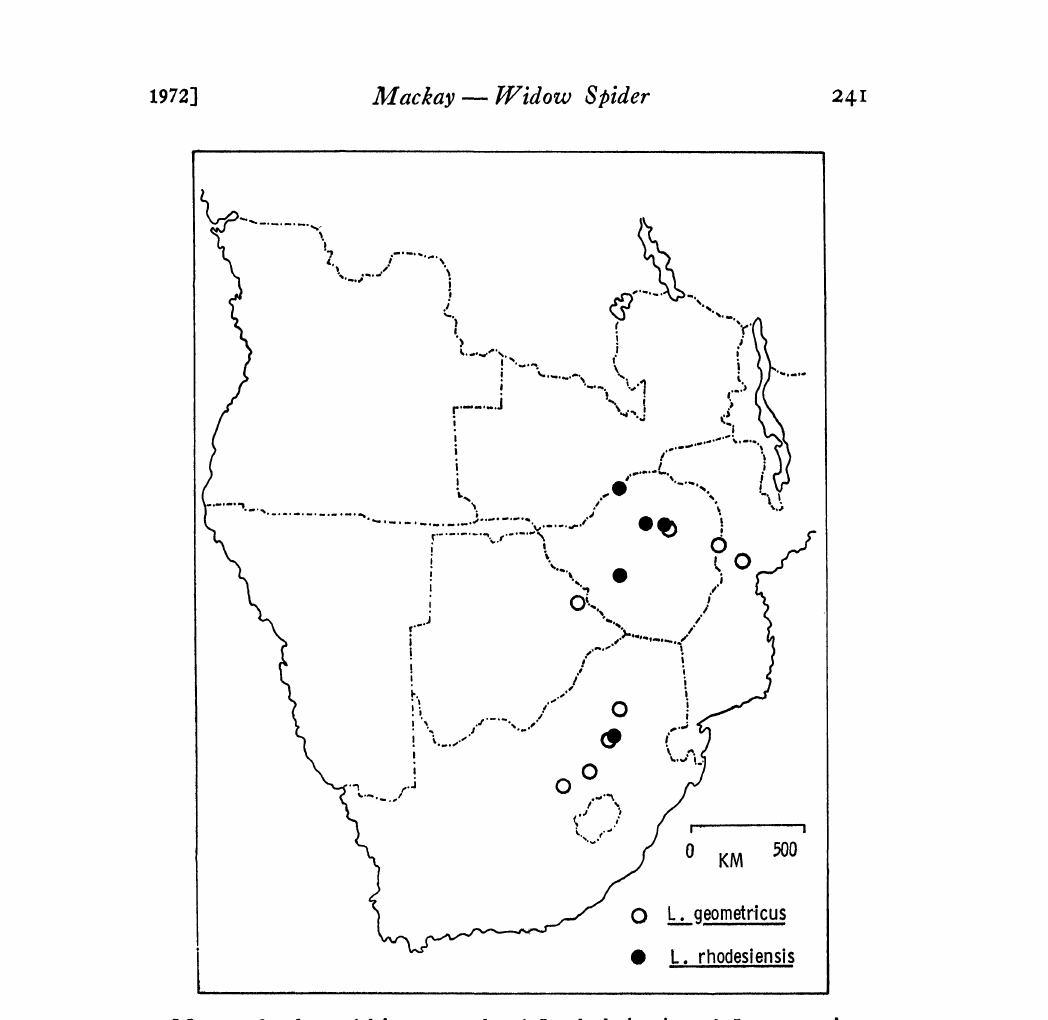
Map 1. Southern African records of L. rhodesiensis and L.